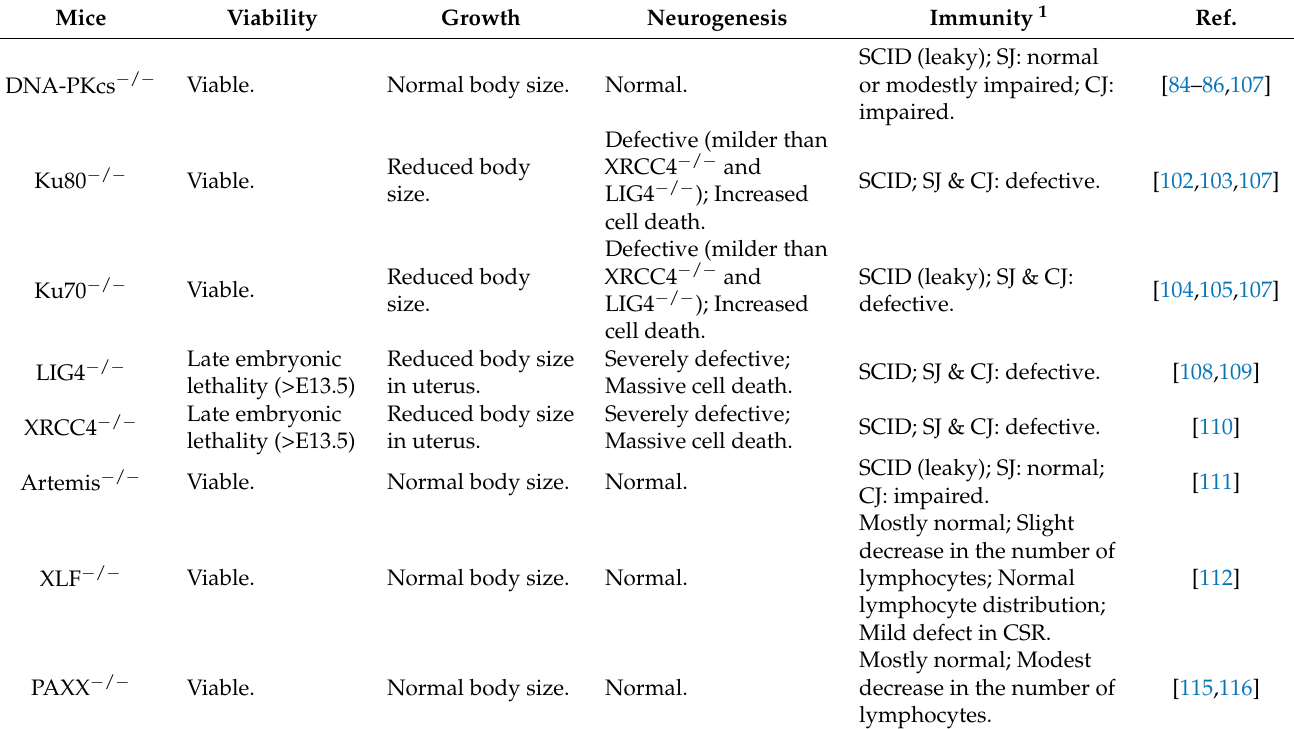
Table 4. Gene knockout mice of DNA-PKcs and other NHEJ